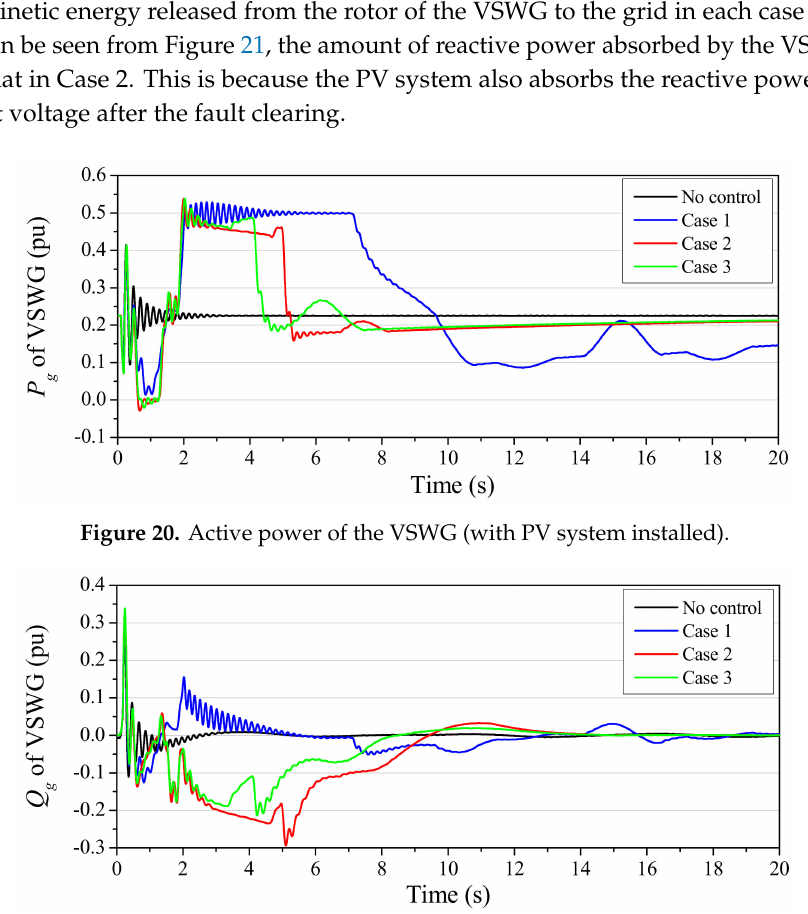
Figure 21. Reactive power of the VSWG (with PV system